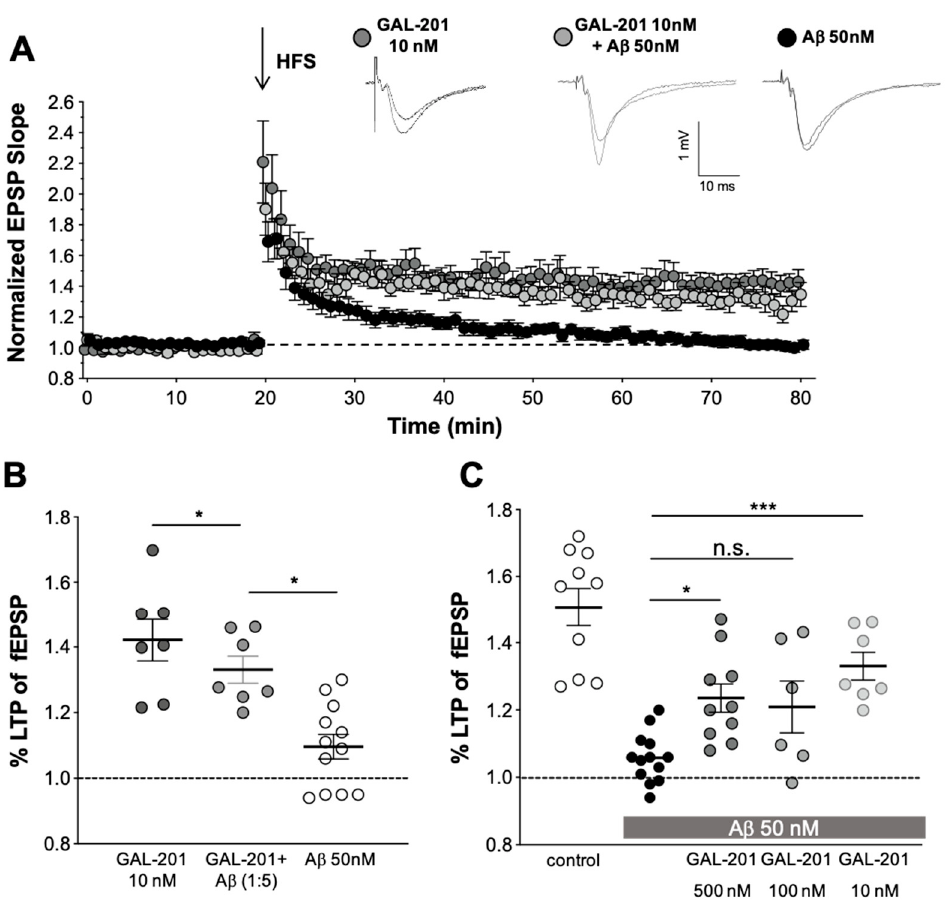
Figure 4. GAL-201 prevented the A β 1-42 -induced LTP blockade in vitro at low concentrations. ( A ) Slices were superfused at 23 ◦ C with 10 nM GAL-201 solution for 90 min before HFS was delivered in the first input (dark gray circles). At that concentration, GAL-201 allowed the induction of LTP. To ensure the validity of the A β 1-42 -mediated effect, interleaved experiments with A β 1-42 (50 nM, closed circles, n = 12) were additionally performed in separate slices. In the presence of A β 1-42 , GAL-201 at 10 nM was able to prevent LTP blockade (light gray circles). Representative fEPSPs are shown on top. ( B ) The magnitude of LTP potentiation in the presence of 10 nM GAL-201, 50 nM A β 1-42 alone, and 10 nM GAL-201 together with 50 nM A β 1-42 is shown as a scatter dot plot representing the potentiation of the fEPSP slope values averaged from the last 10 min of the recordings of each single experiment. The effect of 10 nM GAL-201 in the presence of 50 nM A β 1-42 was significant to 50 nM A β 1-42 alone. ( C ) Scatter dot plot summarizing the last 50 to 60 min after HFS. Effects of different stoichiometric A β 1-42 /GAL-201 ratios (10:1, 2:1, 1:5) on their ability to prevent LTP reduction were investigated. HFS potentiated fEPSP under control conditions and A β 1-42 almost blocked LTP. GAL-201 (500 and 10 nM) significantly prevented LTP in the presence of A β 1-42 . When 100 nM GAL-201 was applied, LTP showed a higher potentiation as with 50 nM A β 1-42 ; however, the effect was not significant. (* p < 0.05, *** p < 0.001). Table 1. Reversal of stoichiometric ratio potentiates detoxifying strength. Concentration GAL-201 500 nM 100 nM Stoichiometric ratio GAL-201:A 1-42 Relative effect size (blocking A 1-42